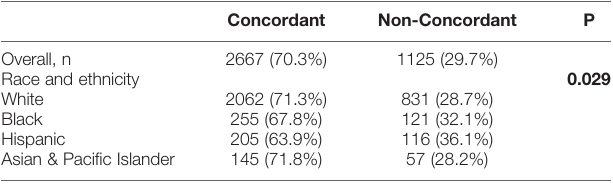
TABLE 3 | Receiving NCCN-Concordant Adjuvant Treatment by Race. TABLE 2 | Survival Analysis, Adjusted Cox Proportional Hazards